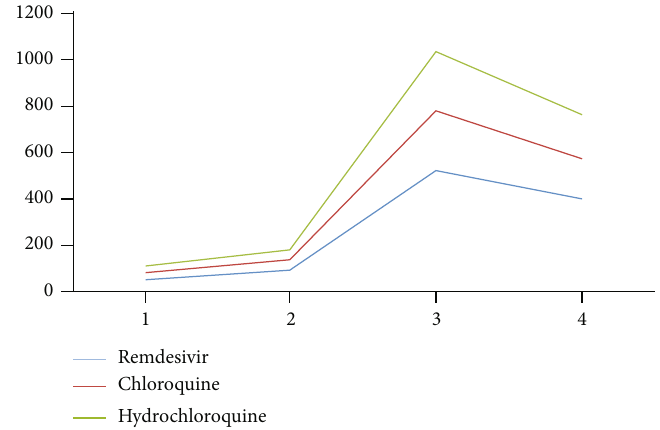
Figure 13: Comparison of remdesivir, chloroquine, and hydroxychloroquine.